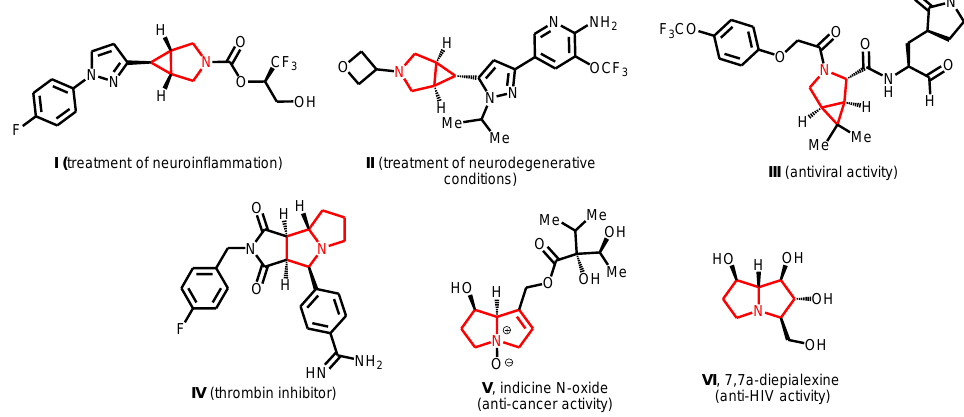
Figure 1. Selected examples of biologically active 3-azabicyclo[3.1.0]hexanes and pyrrolizines.